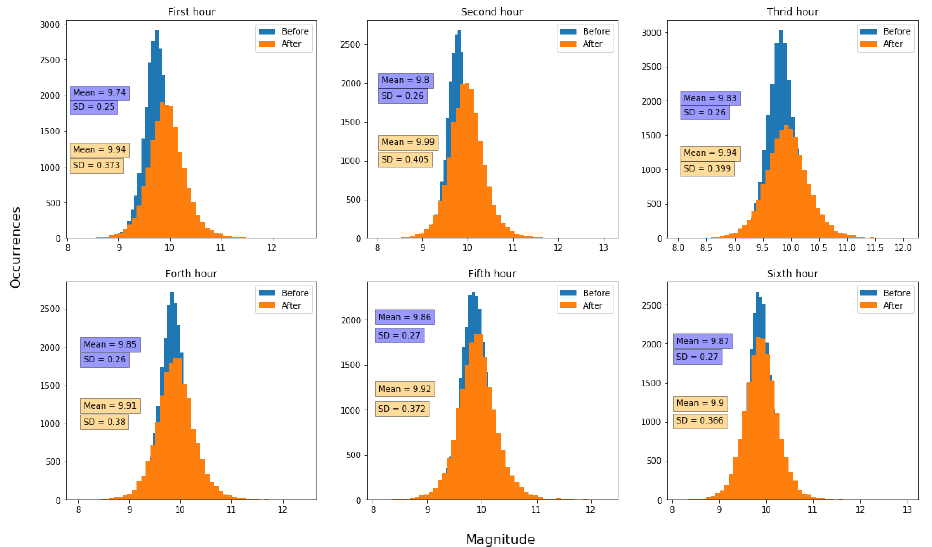
Figure 18. Histogram representation for the inside sensor, before and after inserting the RPWs for the first six hours.